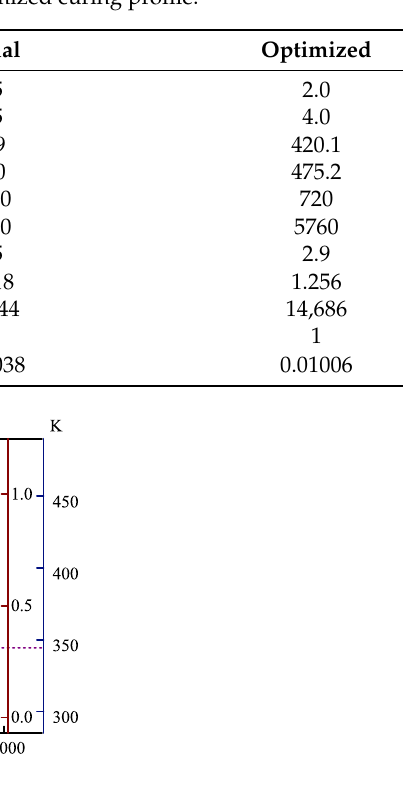
Figure 12. Maximum difference of degree of cure